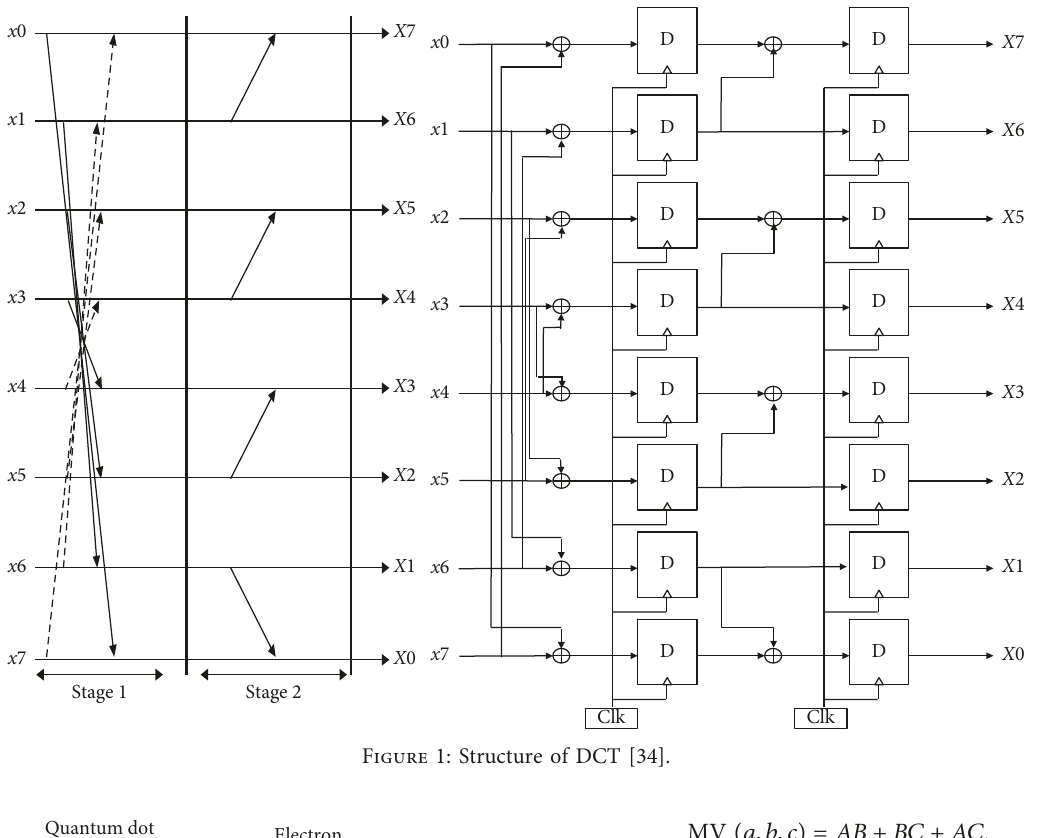
Figure 1: Structure of DCT [34].